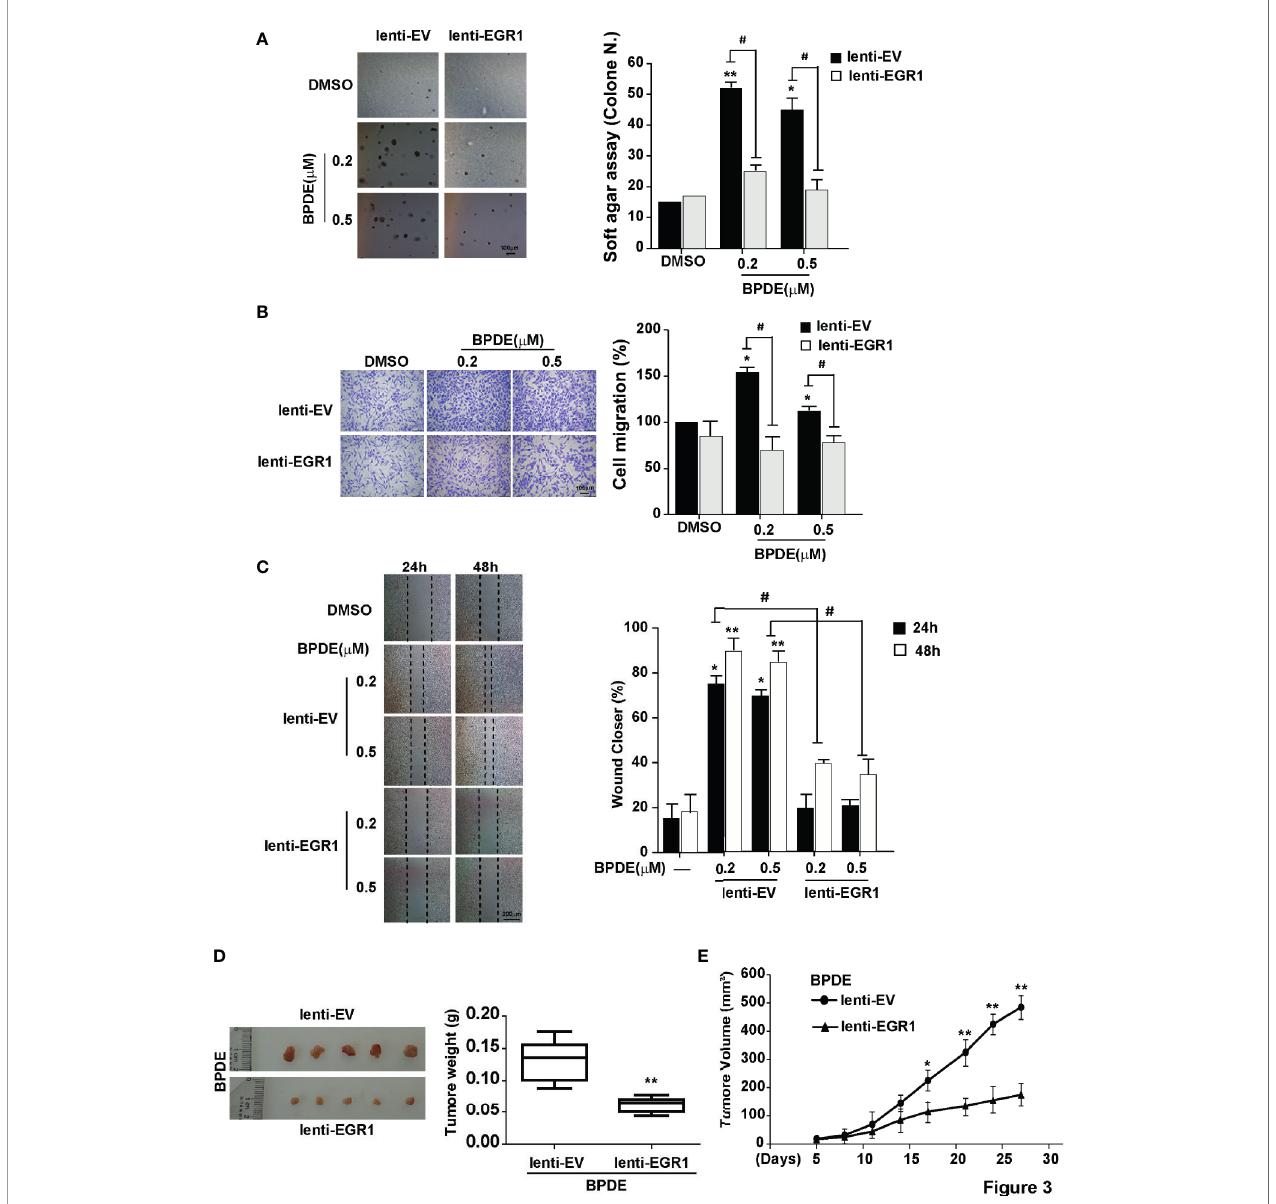
FIGURE 3 | EGR1 downregulation is crucial for BPDE-induced cell malignant transformation. (A) Soft-agar colony formation assays of BPDE-induced transformed cells infected with EGR1 overexpression lentivirus. Left, representative images; right, quantitative results of cell colony per fi eld. (B, C) Left, representative images of transwell migration and wound healing assays; right, relative numbers of migration cell and percentage wound closure after treatment. (D) Representative images of xenograft tumors in nude mice at 4 weeks after inoculation (Left) and the tumor weight of BPDE-induced transformed cells infected with EGR1 overexpression. (E) Tumor growth curve of xenograft assays (n = 10 tumors per group). The analyses were repeated three times, and the results were expressed as mean ± SD. # ,* P < 0.05 and ** P <